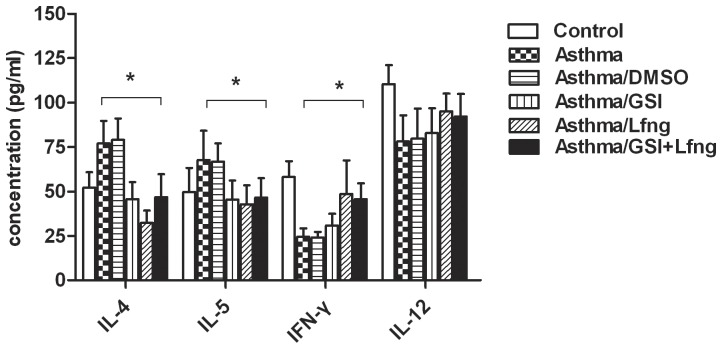
Cytokine production from asthmatic naïve CD4+T cells pretreated with or without GSI.CD4+T cells pretreated with or without GSI and transfected with Lfng cDNA. All the groups, including control group, asthmatic group, asthmatic/DMSO (asthmatic CD4+T treated with DMSO as negative control), asthmatic/GSI (asthmatic CD4+T treated with GSI), asthmatic/Lfng (asthmatic CD4+T treated with Lfng vector) and asthmatic/GSI+Lfng (asthmatic CD4+T treated with GSI and Lfng vector) cells were stimulated by anti-CD3/anti-CD28 antibody and cultured for 3 days. The culture supernatants were collected to detect the IL-4, IL-5, IFN-γ, IL-12 levels by ELISA. *p<0.05. The results are from one representative experiment of three independent experiments. Lfng overexpression almost had the same effect as GSI blockage on Th2 cytokine promotion (IL-4, IL-5) but had a greater effect on Th1 cytokines (IFN-γ, IL-12) than GSI treatment.